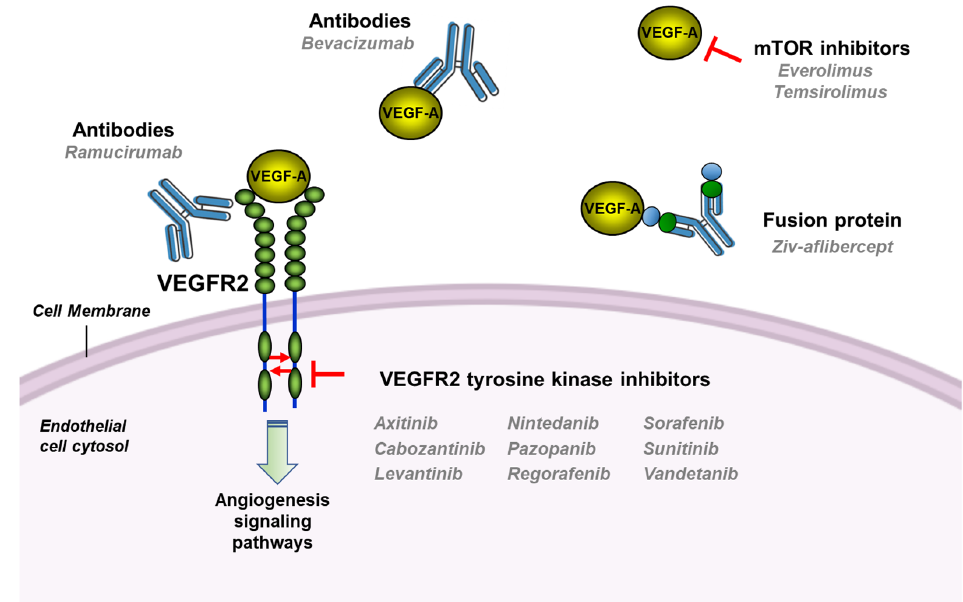
Figure 3. Main molecular targets for the antiangiogenic drugs approved in oncology.